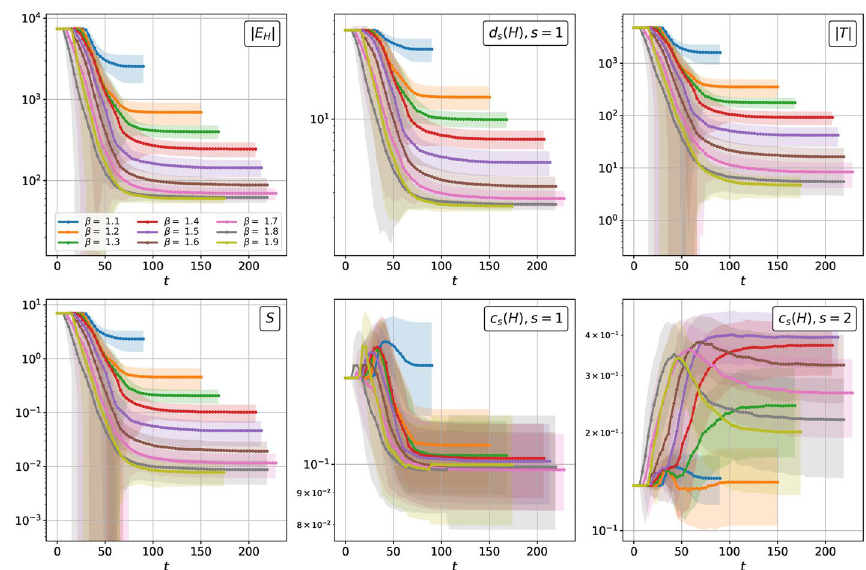
Fig. 6 Evolution of hypernetwork properties. Mean (markers) and standard deviations (shades around the markers) of number of hyperedges | E H | (upper left), number of triangles | T | (upper center), covered area S ( H ) (upper right), average 2-degree d 2 ( H ) (lower left), average 1-closeness centrality c 1 ( H ) (lower center) and 2-closeness centrality c 2 ( H ) (lower right), computed for different values of β as a function of